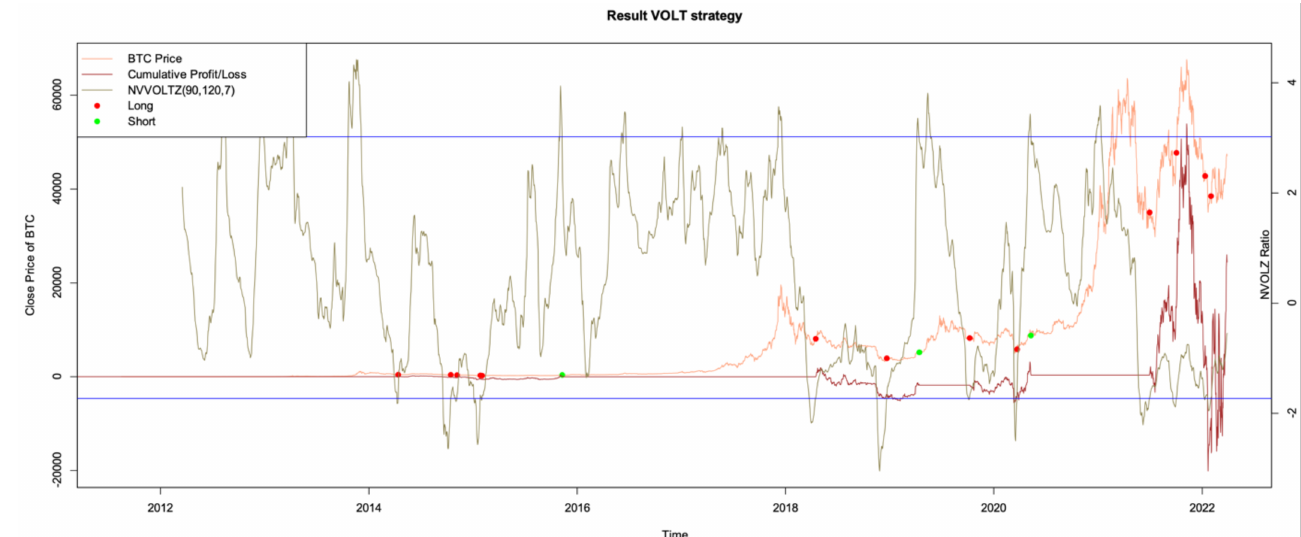
Figure A7. VOLT strategy: BTC price (orange line, left-hand side), cumulative profit/loss (red line, left-hand side), VOLT ratio (brown line, right-hand side), long and short thresholds (blue lines, right-hand side), long orders (red points), and short orders (green